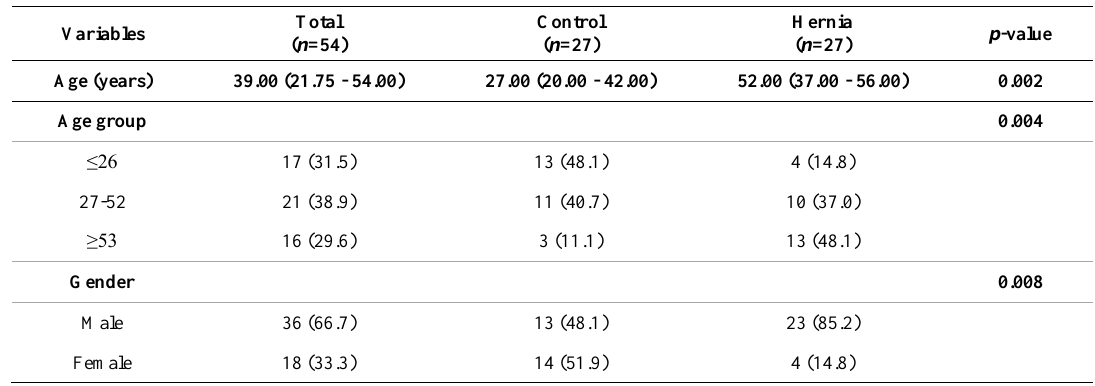
Table 1. Sociodemographic characteristics of the subjects stratified by hernia and control groups, at the Mankranso Hospital,